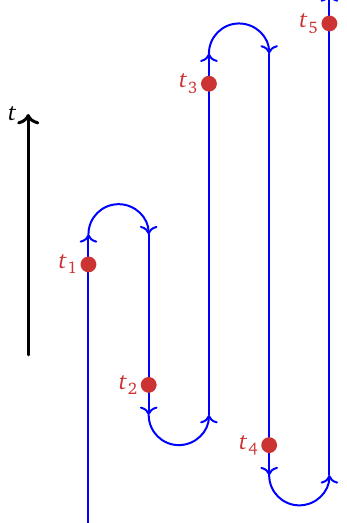
Figure 1: The timefolded contour necessary to compute the correlator with temporal > t < t > t < t ordering t , t , t and t . In the above we have drawn the time 1 2 2 3 3 4 4 5 running upwards, but soon we will switch to a notation where forward evolution runs left to